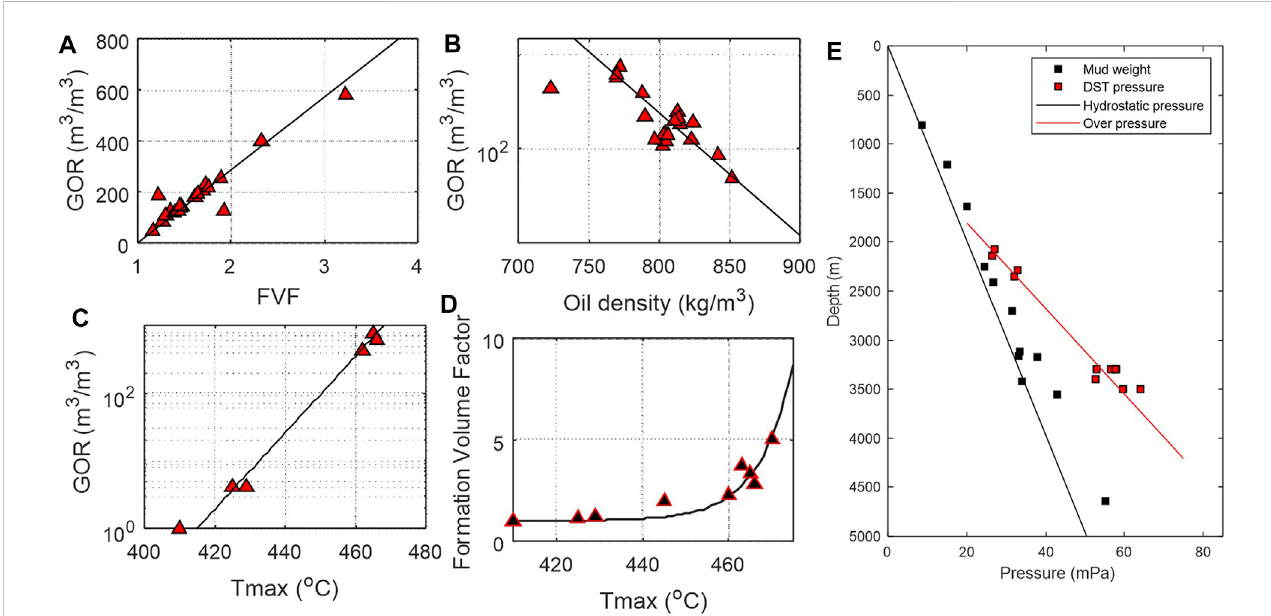
FIGURE 6 Cross-plots ofreservoirparametersoftheDuvernayShale showinggeneralcharacteristicsofpetroleum fl uidsatsurfacecondition(modi fi edfromChen andJiang,2020). (A) GastooilratioGORvsformationvolumefactorVFV; (B) GORvsoildensity; (C) GORvsmaturityindexTmax; (D) Formationvolumefactor FVF vs maturity index Tmax. (E) Reservoir pressure pro fi le of the liquid-rich Duvernay shale.